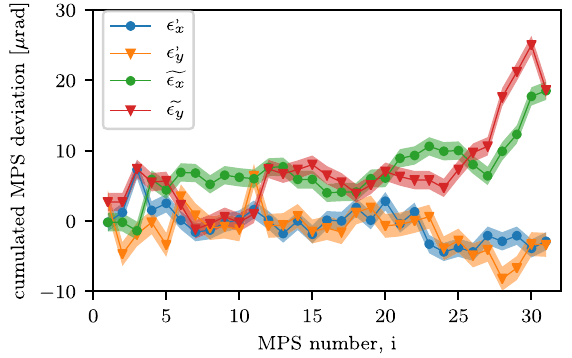
FIG. 18. Measured cumulated angular beam deviation with ( ϵ ; x ; ϵ ; y ) and without ( ˜ ϵ ; x ; ˜ ϵ ; y ) the cascade cumulated deviation error correction.